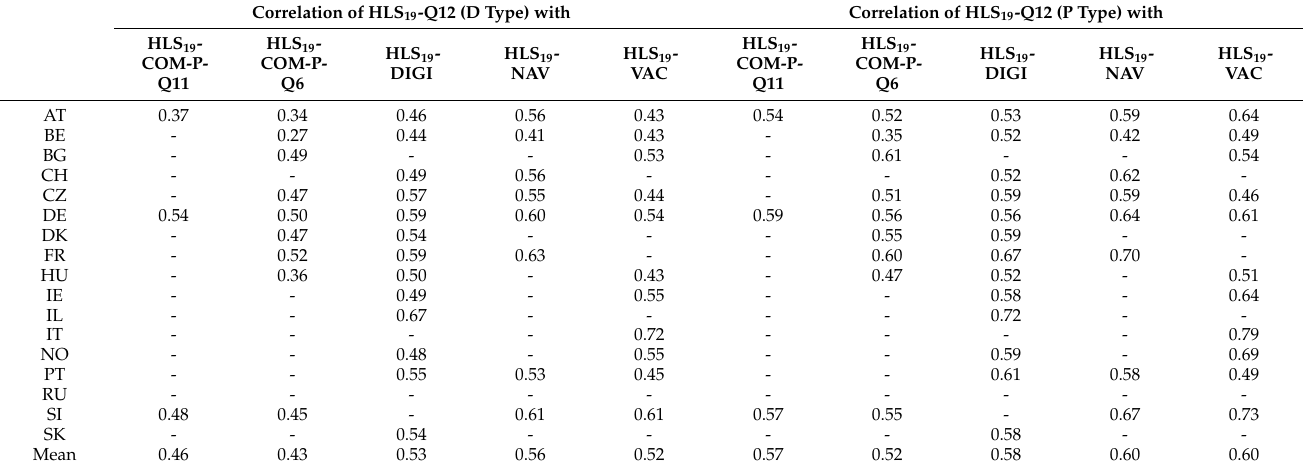
Table 12. Weighted Pearson correlation of HLS 19 -Q12_score with HLS 19 scores for special health